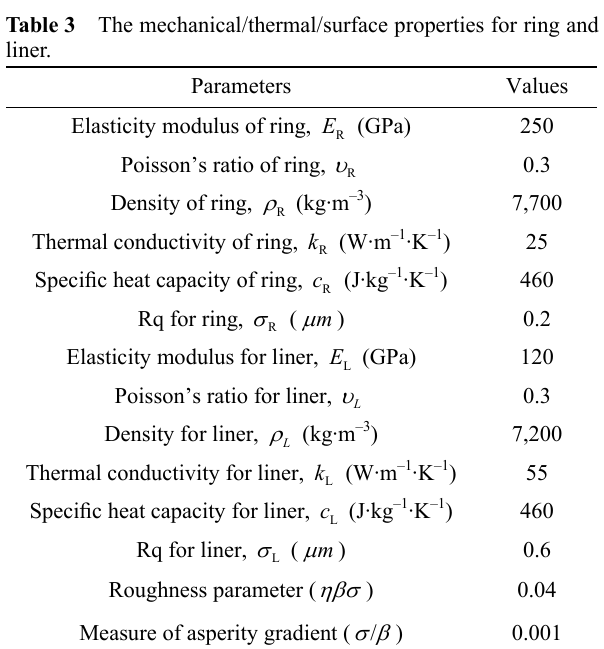
Table 3 The mechanical/thermal/surface properties for ring and liner.